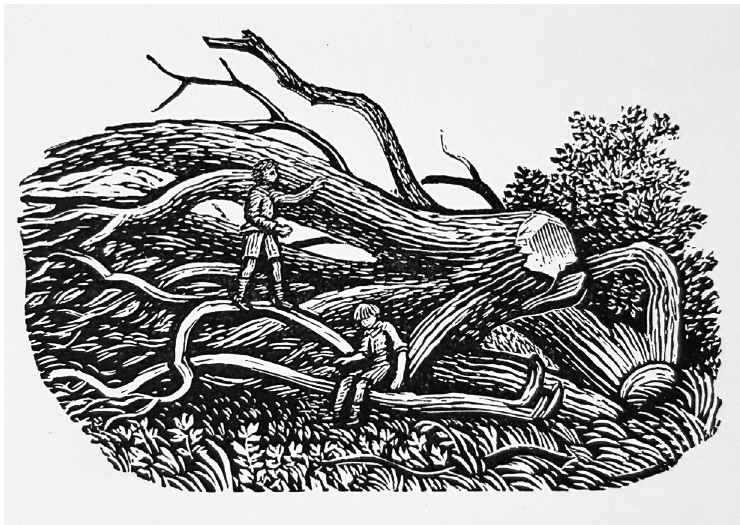
Figure 4 Illustration for Boxwood poem III. Image courtesy of the Estate of Reynolds Stone.